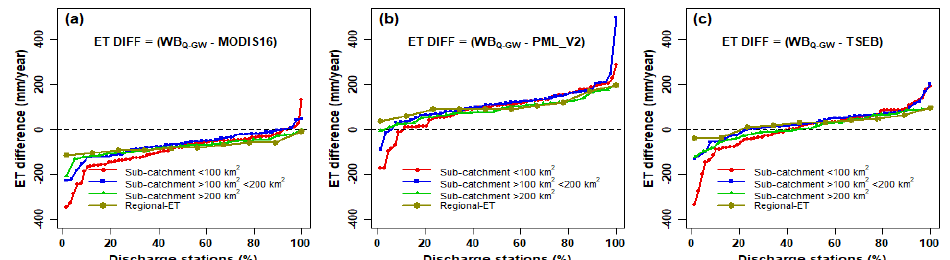
Figure 9. Catchment size-based ET differences between the modified surface WB method and RS ET models of ( a ) MODIS16, ( b ) PML_V2, and ( c ) TSEB. Different point symbols of filled circle, square and triangle (star) on the lines represent individual catchment (aggregated catchment). For more information about the size and numbers of the sub-catchments, it is referred to Figure 1.